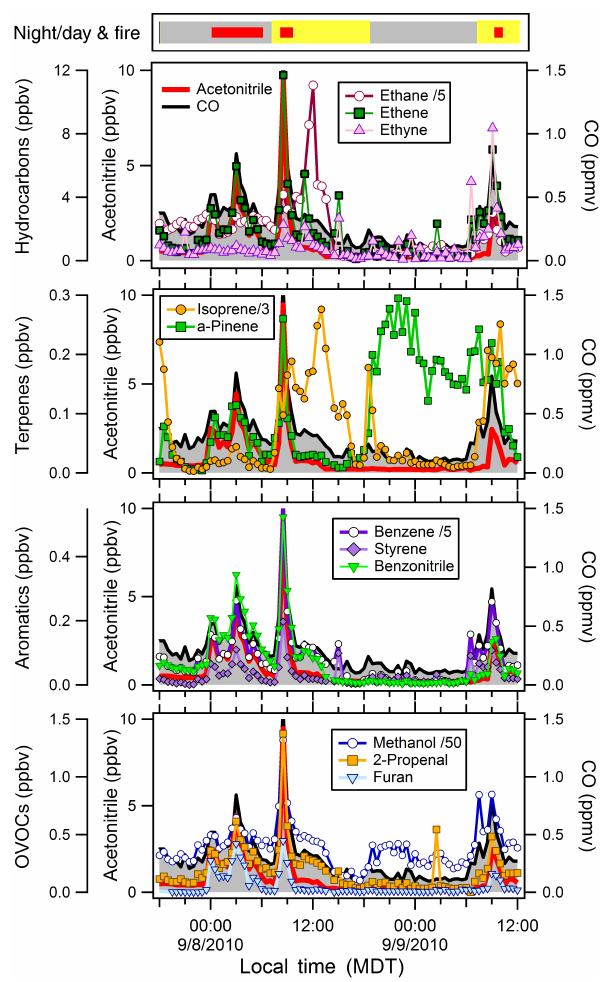
Figure 6. Time series of ambient air measurements in Boulder, CO during the Fourmile Canyon Fire. The top bar indicates nighttime (grey), daytime (yellow), and biomass burning plumes (red mark- ers). CO and acetonitrile are included in all 4